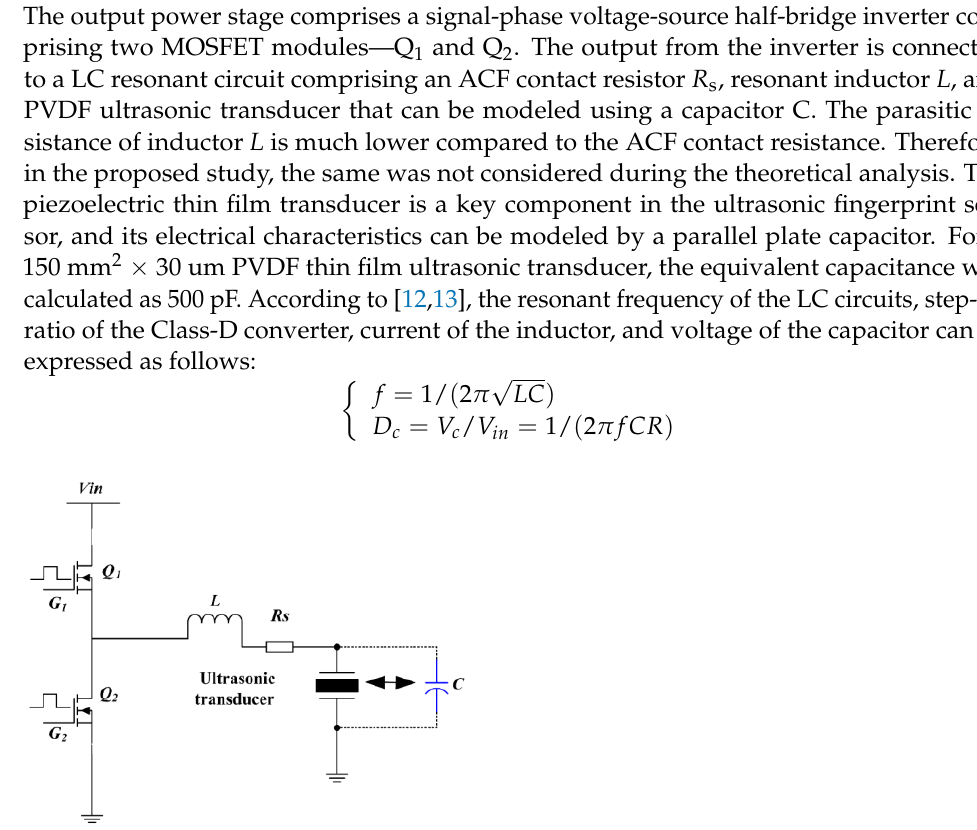
Figure 3. Schematic of a traditional Class-D converter.